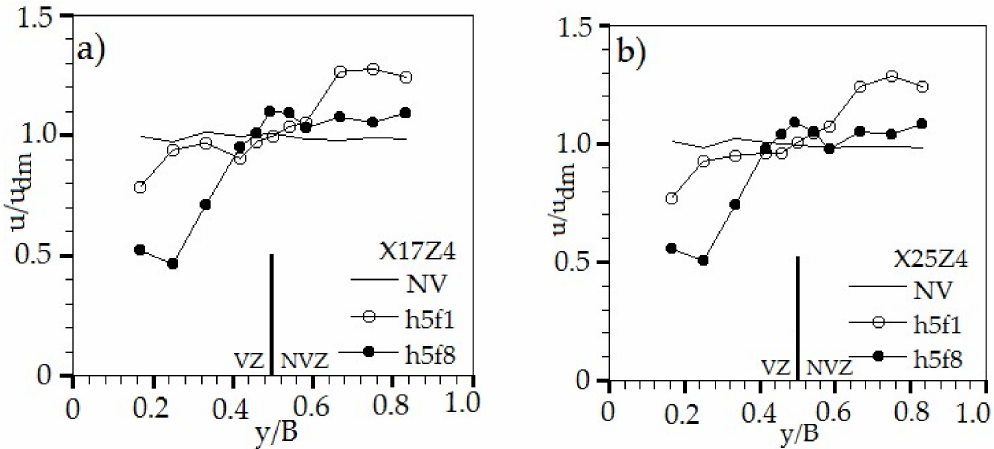
Figure 10. Non-dimensional streamwise velocity distributions along the spanwise direction at z / h v = 1.5 for h v = 0.05 m and different SVFs; ( a ) X17; ( b )